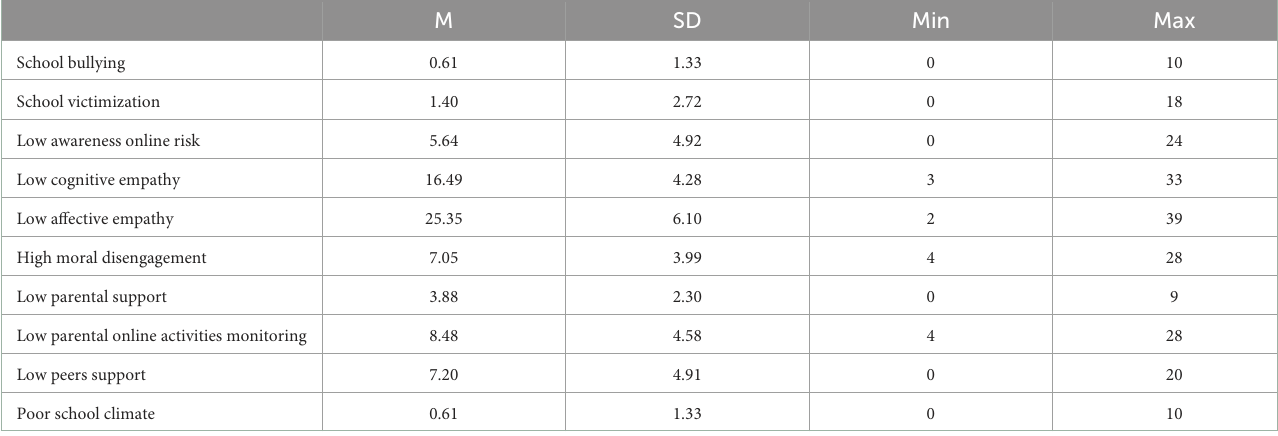
TABLE 4 Descriptive statistics of onset of cybervictimization ( N = 175).